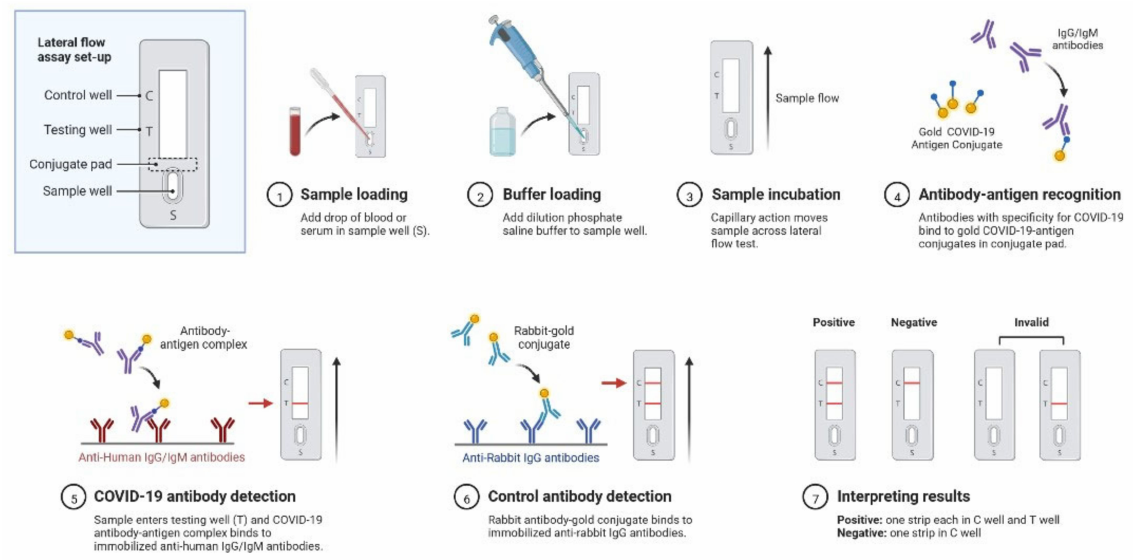
Figure 3. Representations of COVID-19 serologic diagnostic testing through antibody detection. It depicts sample loading, SARS-CoV-2 antibody-antigen detection, and qualitative test